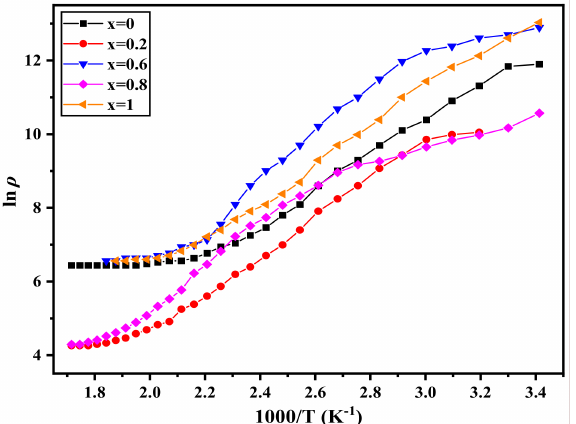
Figure 11. The variation of DC resistivity as a function of the reciprocal temperature of